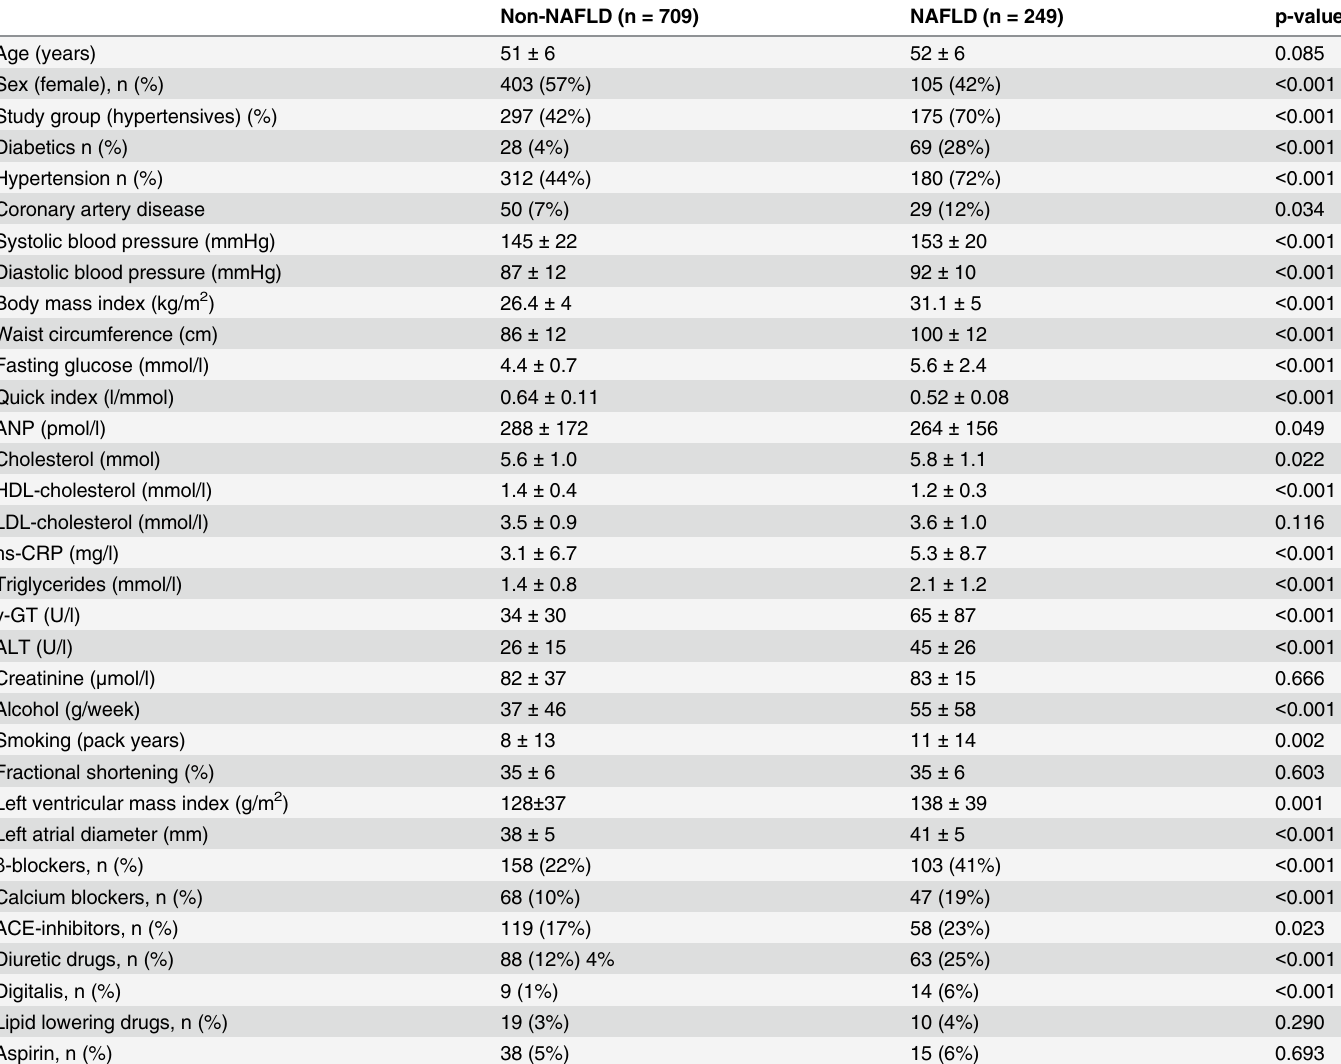
Table 1. Baseline characteristics of the study subjects (n = 958) according to the presence or absence of